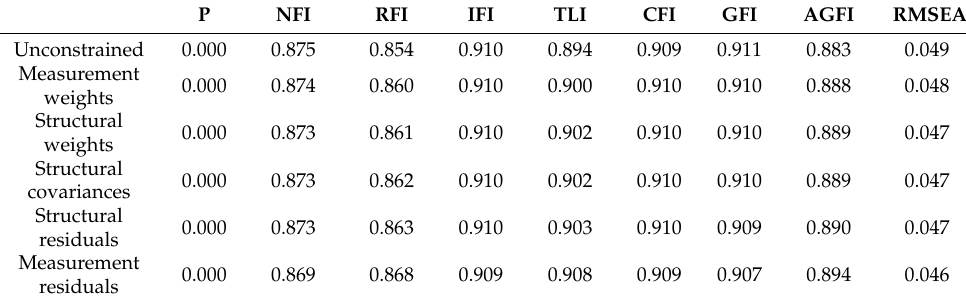
Table 7. Results of indicators of multi-group SEM model fitness by gender.